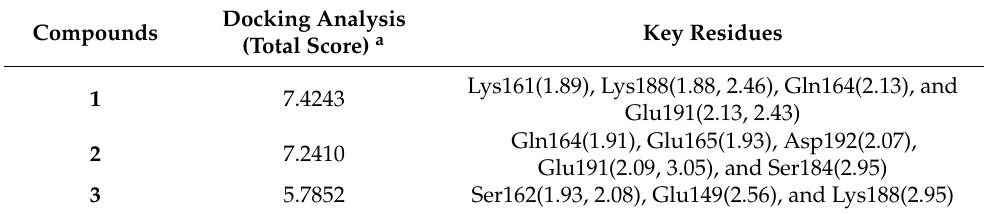
Table 3. Molecular docking results of isolated compounds 1 – 3 on TSLP/TSLPR